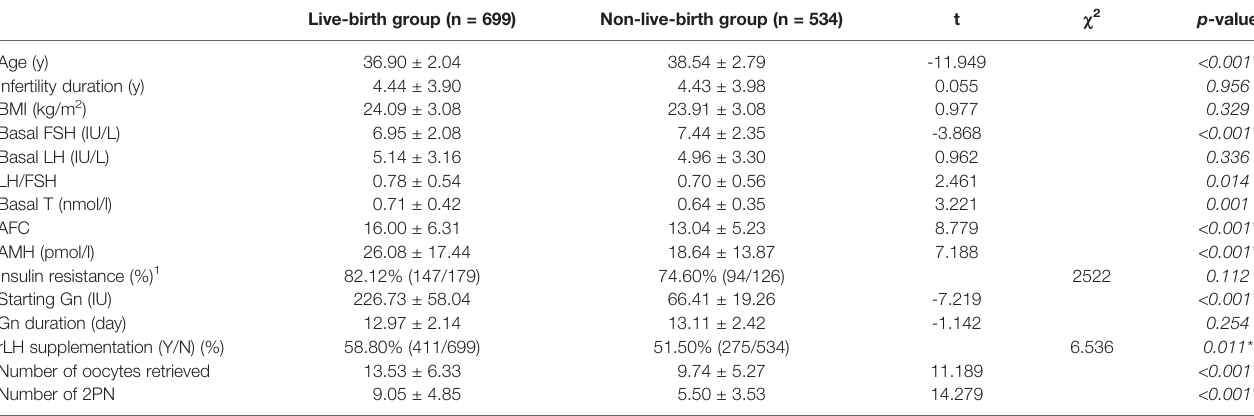
TABLE 2 | Demographics and IVF/ICSI treatment characteristics of the live-birth and the non-live-birth groups of fresh cycles. Live-birth group (n = 699) Non-live-birth group (n = 534) Age